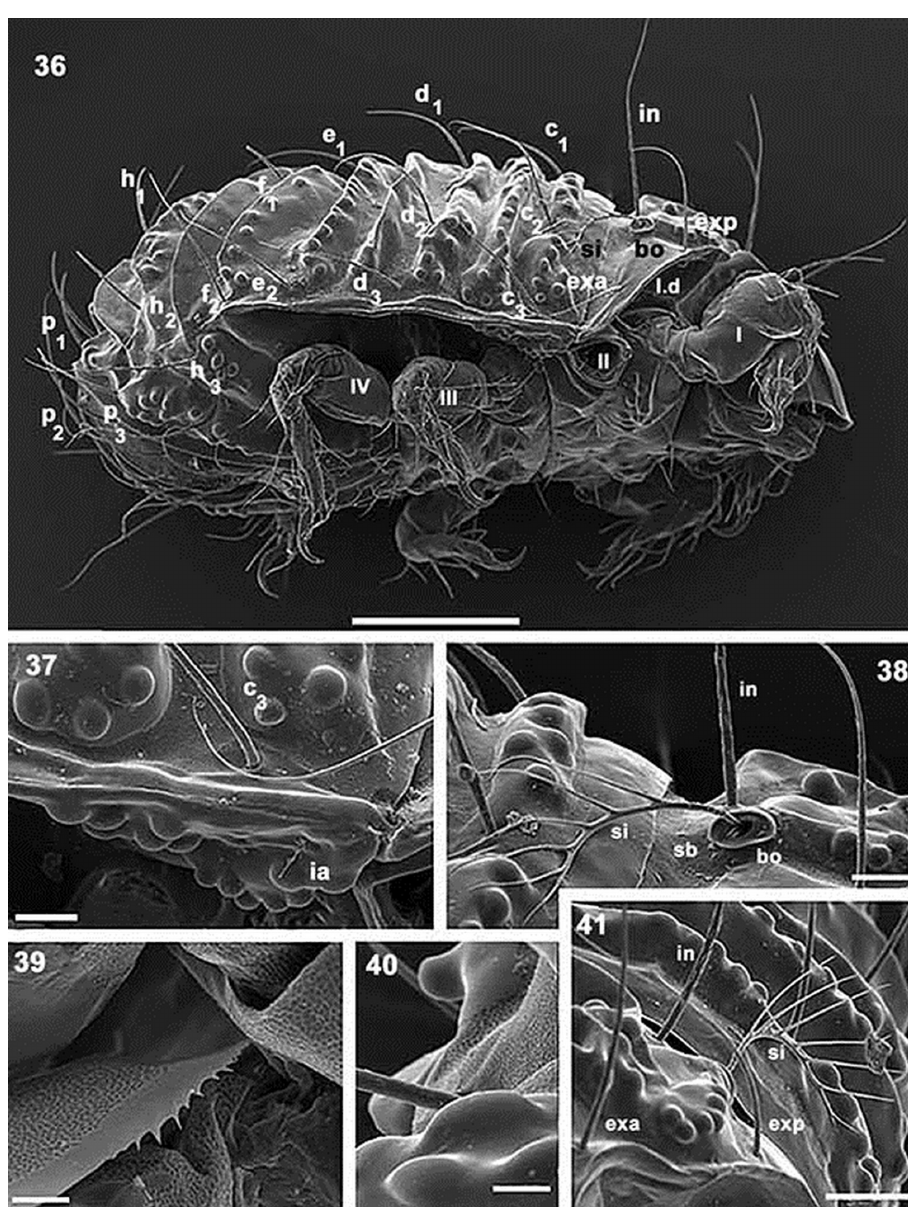
Figures 36–41. Paulianacarus costaricensis sp. n. Adult with cerotegumental layer. SEM. 36 lateral view 37 anterior lateral notogastral zone 38 bothridial zone 39 prodorsal marginal zone 40 promonto- ries 41 lateral view, sensillus zone. Abbreviations: See Material and methods. Scale bars: 36 = 200 μm; 37 = 20 μm; 38 = 50 μm; 39 = 10 μm; 40 = 10 μm; 41 = 50